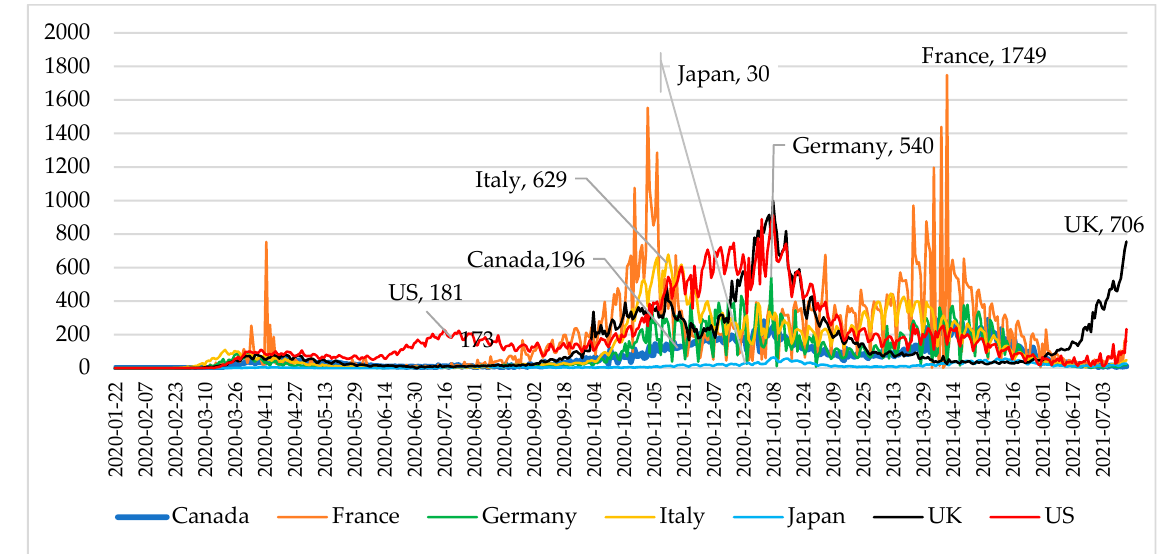
Figure A2. COVID-19, new cases per million population in G7 countries. Source of data: Oxford University’s Our World in Data (OWID) database.